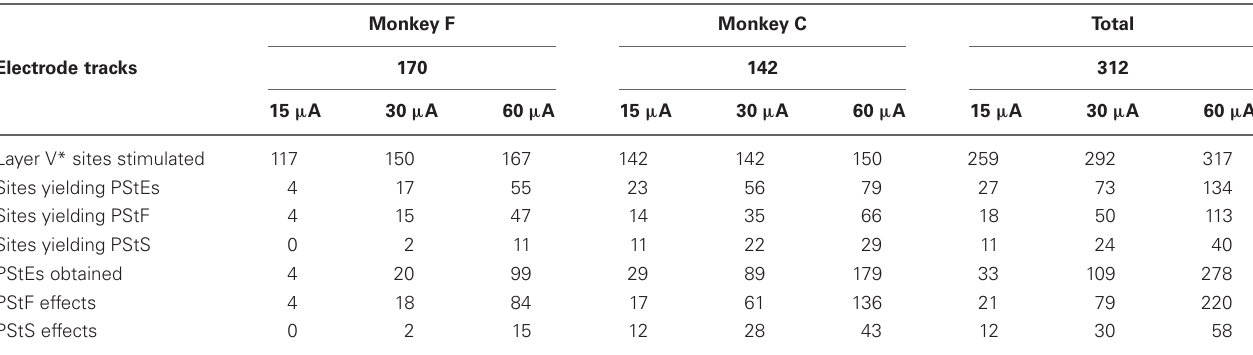
Table 1 | Summary of data collected from ankle